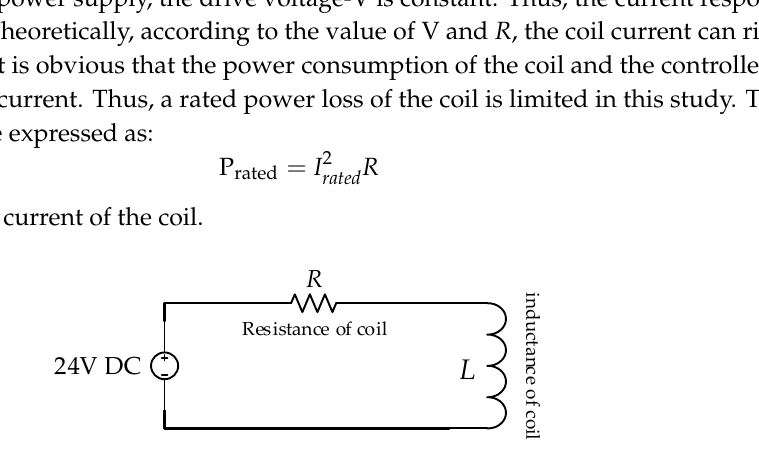
Figure 11. Simplified equivalent circuit of the LPS coil.